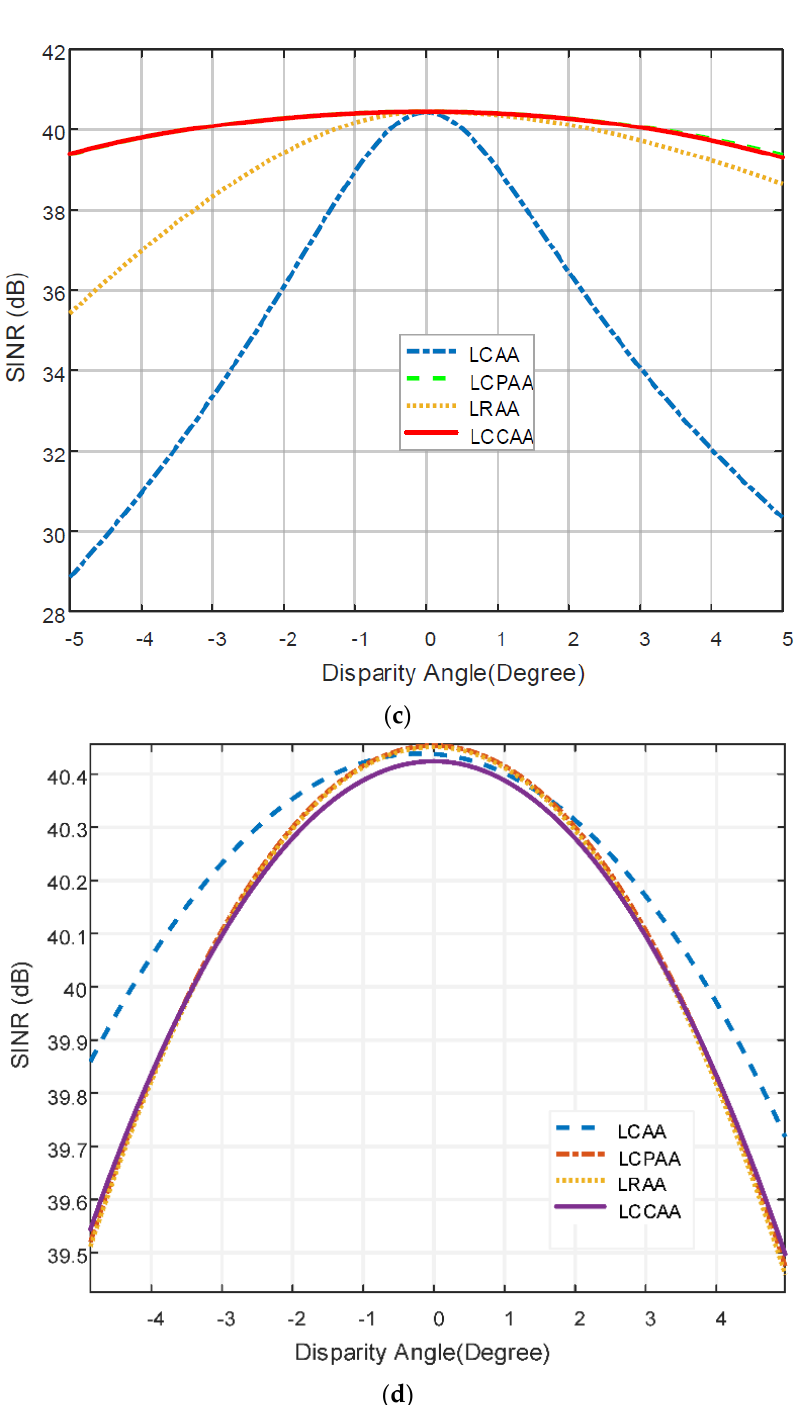
Figure 3. ( a ) SINR comparison of FDL-based beamformer with respect to the disparity angle. ( b ) SINR comparison of ODL-based beamformer with respect to the disparity angle. ( c ) SINR comparison of VDL-based beamformer with respect to the disparity angle. ( d ) SINR comparison of the NVL-based beamformer with respect to the disparity angle.